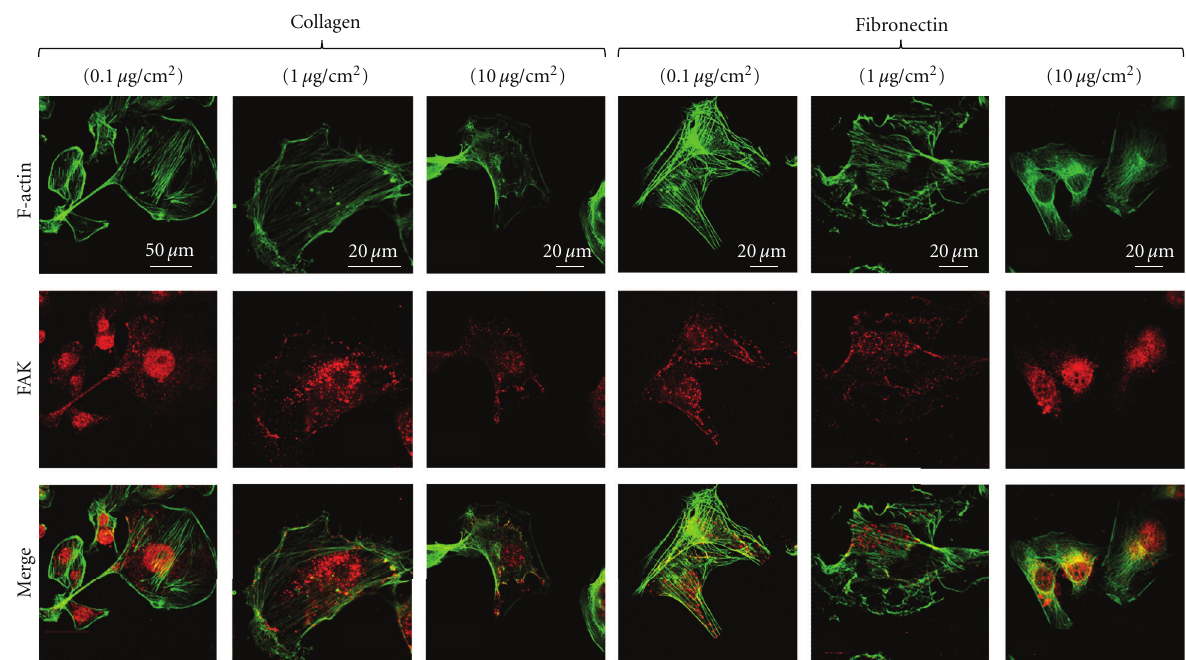
Figure 3: ECM density-dependent cytoskeletal architecture and focal adhesions of MDA-MB-231 cells. MDA-MB-231 cells were cultured on varying density collagen and fibronectin-coated surfaces. Cells were fixed after 24 hours in culture and stained for F-actin (green) and focal adhesion kinase (FAK) (red). Merged images show the colocalization of the actin fibers and FAK at the points of focal adhesion formation (yellow). Prominent stress fibers were observed across all the conditions. Cells plated on 0.1 μ g/cm 2 collagen-coated substrates were more rounded and exhibited nuclear/perinuclear FAK localization. At higher collagen concentrations, cells became more elongated with FAK- positive peripheral focal adhesions. FAK localization on fibronectin-coated substrates exhibited an opposite trend to that on collagen-coated substrates with peripheral adhesions at lower densities and nuclear/perinuclear staining at higher